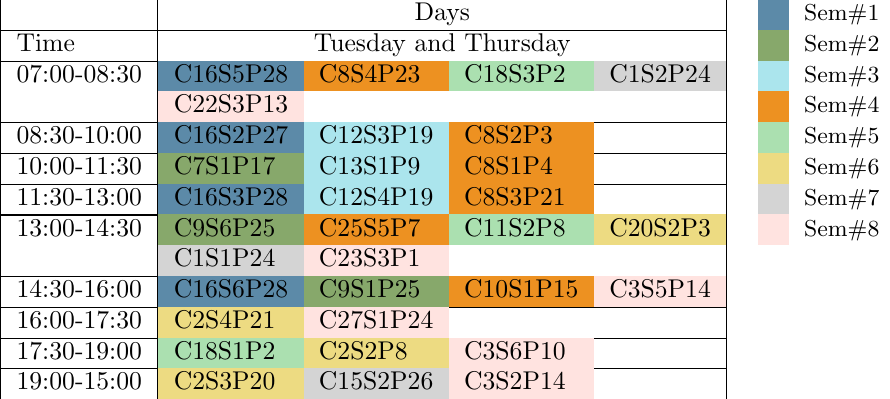
Figure 5. Timetable of second strategy for courses in day scheme B: Tuesday and Thursday, two classes of 1 h and a half per